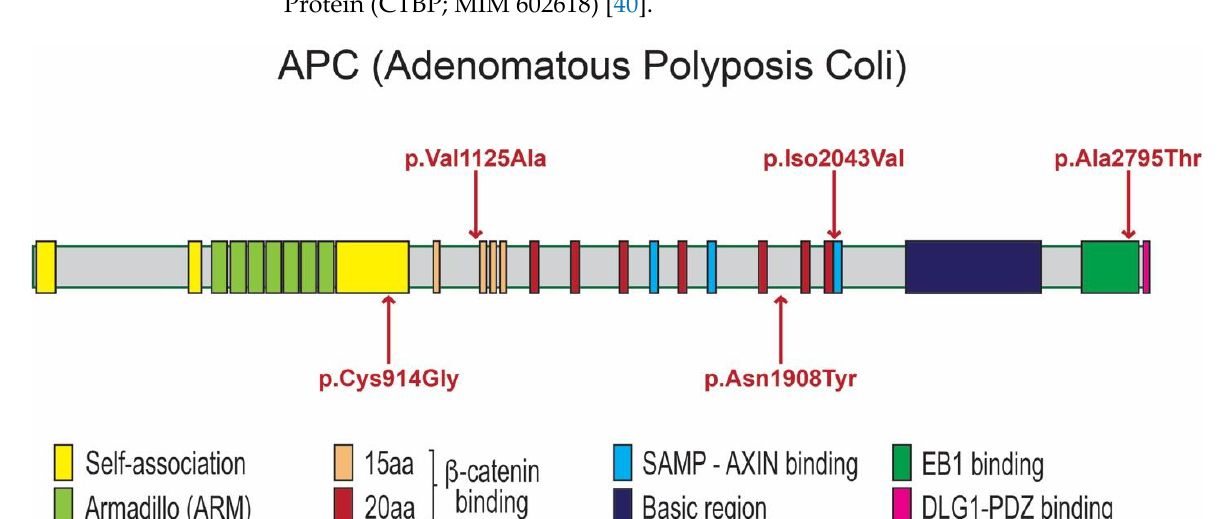
Figure 4. Protein domains of APC proteins. APC is comprised of regions required for oligomeriza- tion, Armadillo repeats, β -catenin-binding domain, AXIN-binding domain, Basic domain, EB1- binding domain, and HDLG-binding domain. Locations of mutations are indicated by red arrows.